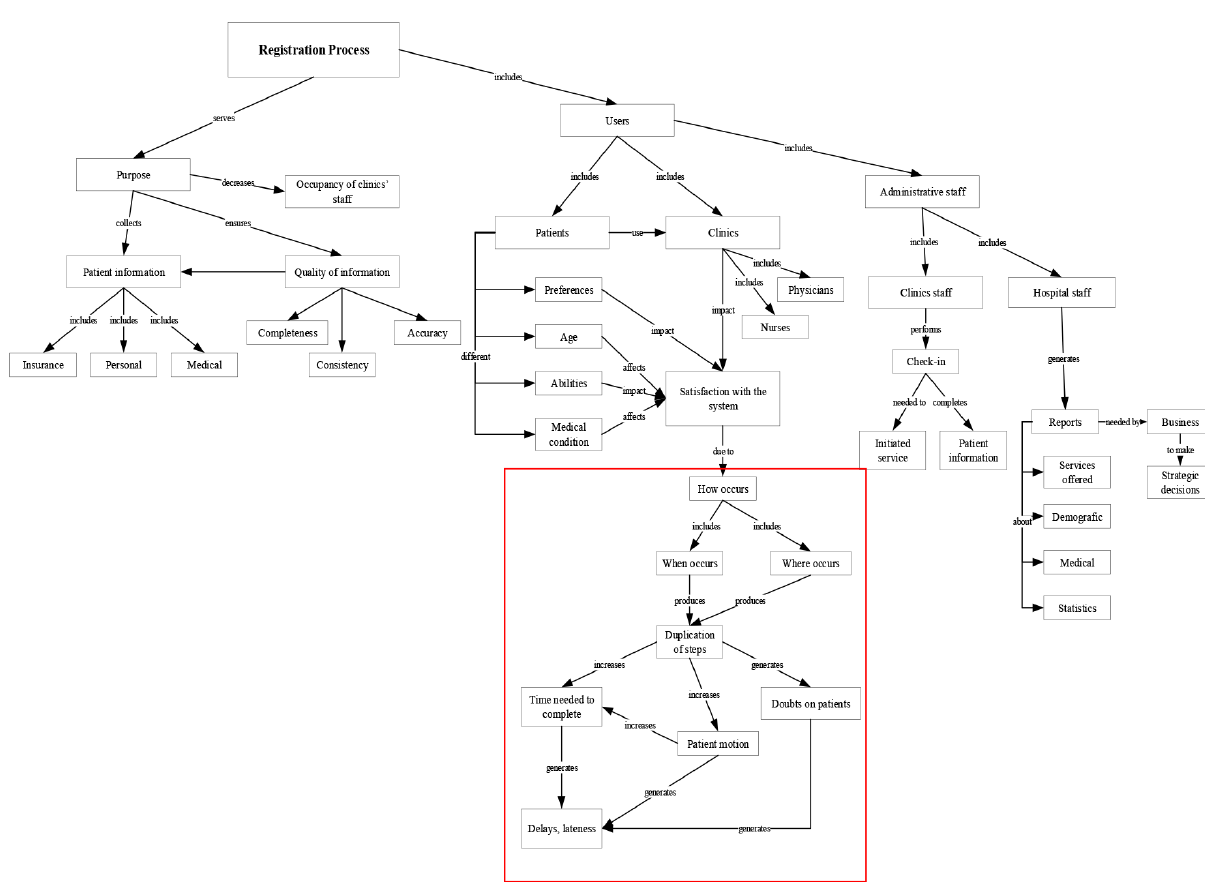
Figure 3. Concept map of the registration process (Current